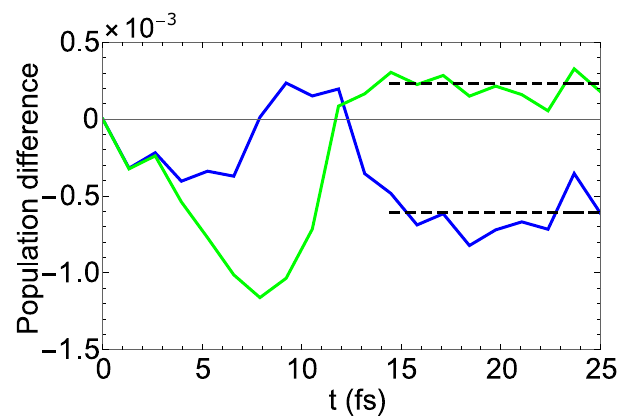
Fig. 9 Exciton population differences. p 7 − (0.05 + p 1 ) (green) and p 8 − (0.05 + p 3 ) (blue), compare Fig. 8. Black dashed lines indicate the average in the respective region.